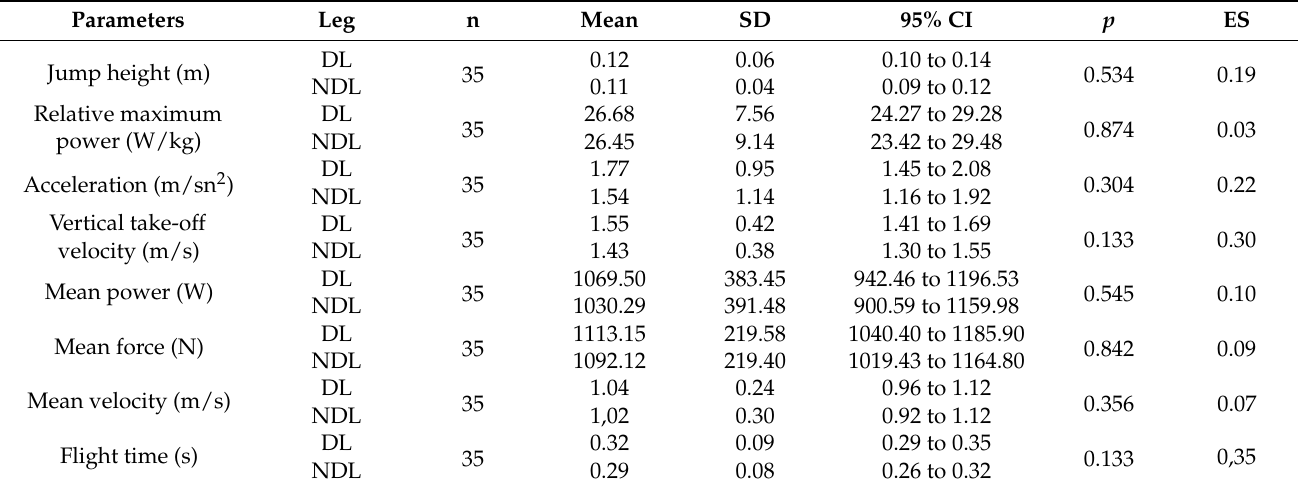
Table 5. Comparison of dominant and non-dominant leg CMJ